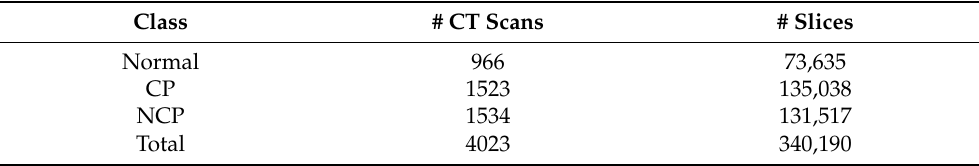
Table 2. CLEAN-CC-CCII dataset. This table reports the number of chest CT scans and slices for the CLEAN-CC-CCII dataset. The last row reports the overall size of the dataset.